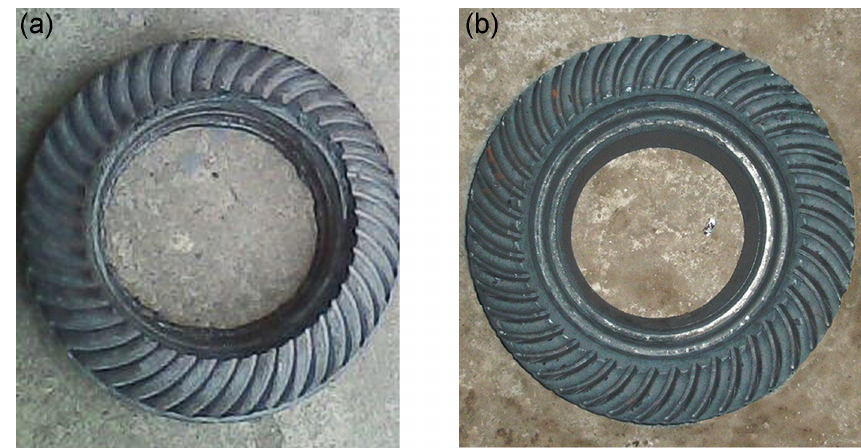
Figure 17. Different eccentricity products. (a) e 1 /e 2 = 2, (b) e 1 /e 2 = 3.